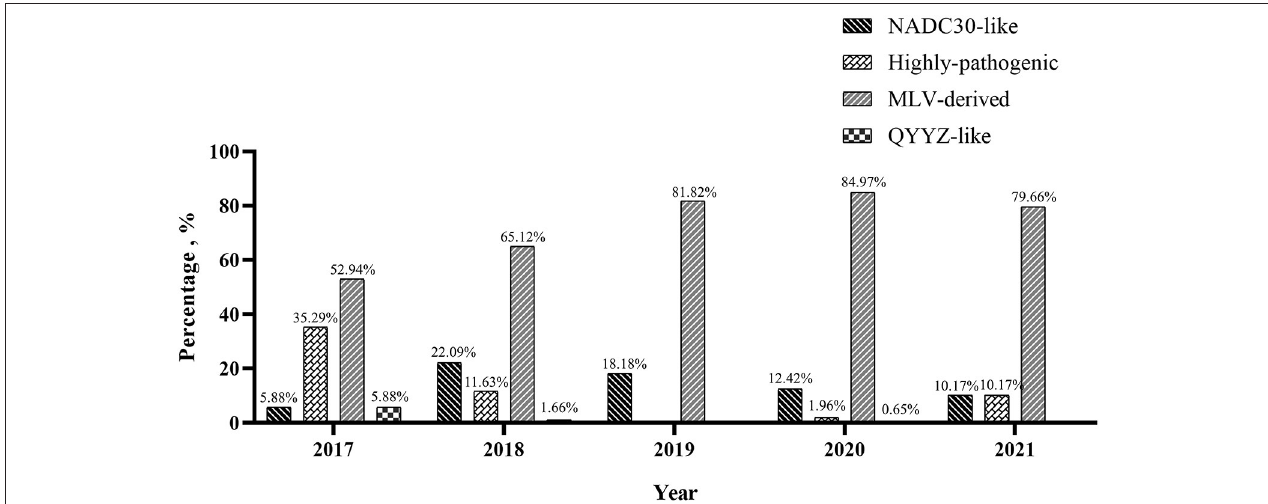
FIGURE 3 | Annual detection rate of highly-pathogenic PRRSVs, MLV-derived PRRSVs, NADC30-like PRRSVs and QYYZ-like PRRSVs in South China between 2017 and 2021.